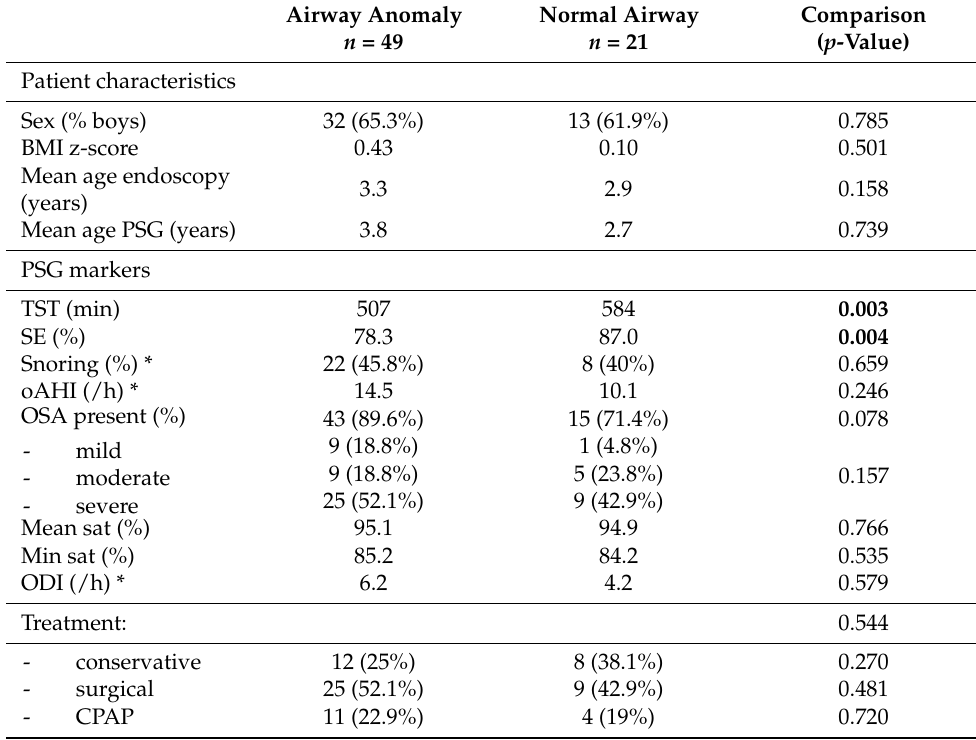
Table 1. Patient characteristics, PSG markers, and choice of treatment in children with DS; compared between the group with and without lower airway anomalies. Airway Anomaly Normal Airway Comparison n = 49 n = 21 ( p -Value) Patient